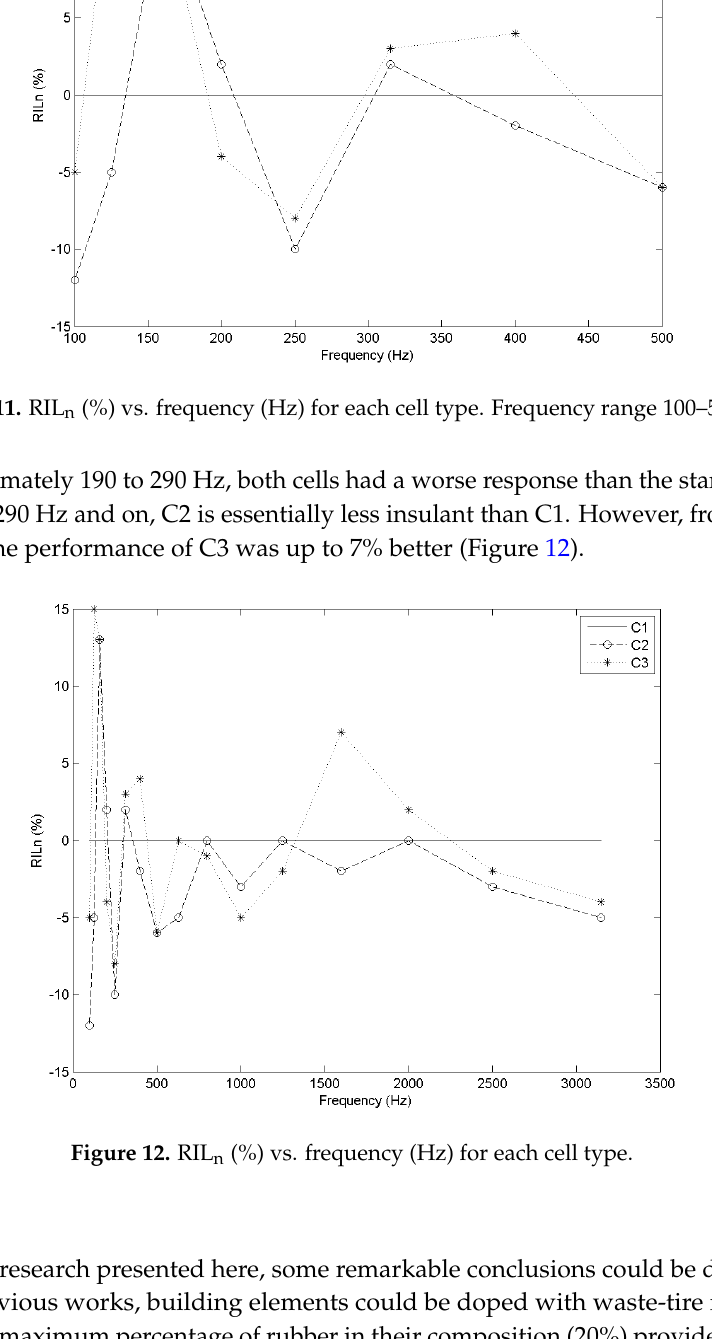
Figure 12. RIL n (%) vs. frequency (Hz) for each cell type.